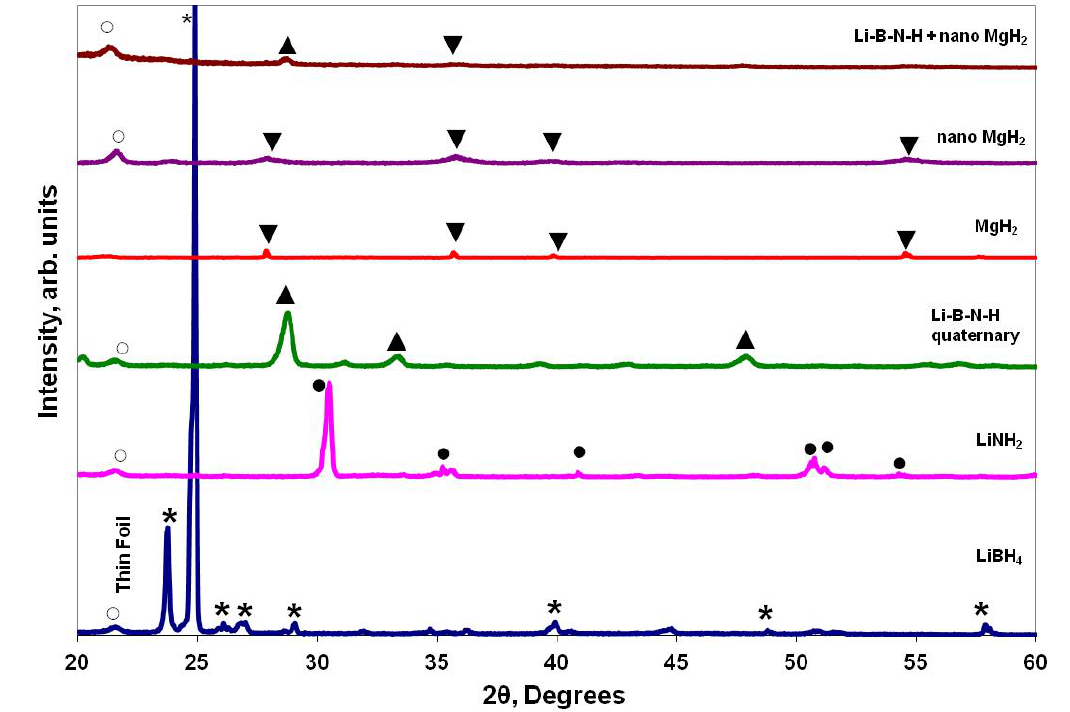
Figure 2. FTIR spectra of the plain LiBH /2LiNH /nanoMgH LiBH 4 2